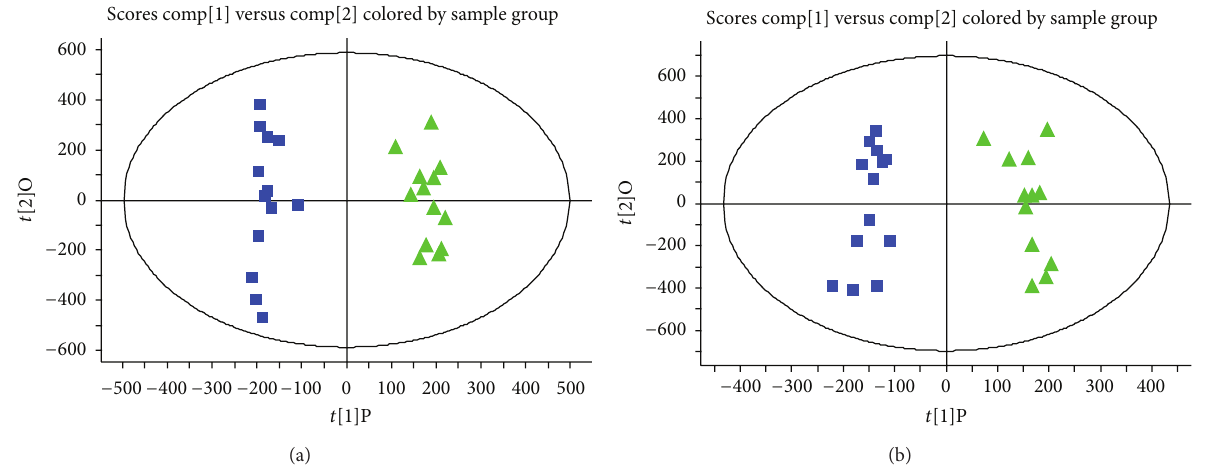
Figure 3: Score plots of OPLS-DA in human serum samples between C group ( ◼ ) and SHLI group ( 󳵳 ) in (a) positive ion mode and (b) negative ion mode.